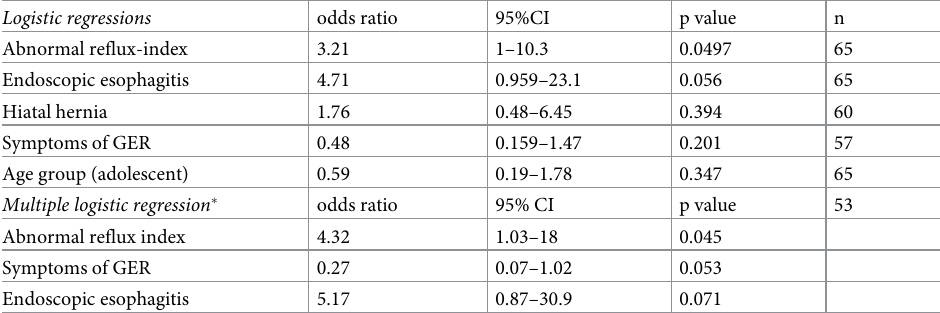
Table 4. Logistic regression model for factors associated with histopathological esophagitis. Logistic regressions odds ratio 95%CI p value Abnormal reflux-index 3.21 Endoscopic esophagitis Hiatal hernia 1.76 Symptoms of GER Multiple logistic regression � odds ratio 95% CI 53 Abnormal reflux index 4.32 Symptoms of GER Endoscopic esophagitis 5.17 0.071 � Hiatal hernia and age group were excluded from the final model by stepwise